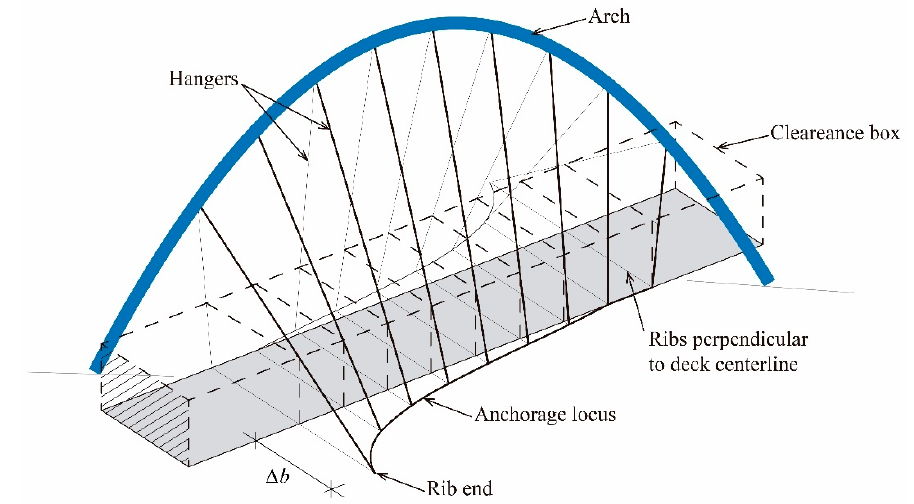
Figure 23. 3D Scheme of possible widening of the deck because of clearance restrictions.